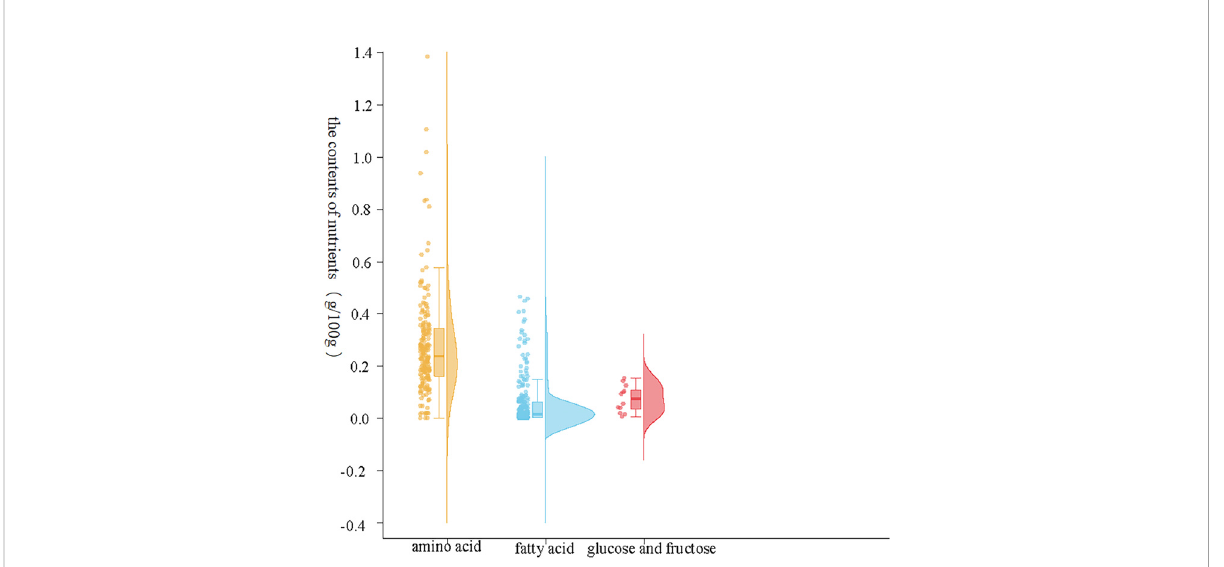
FIGURE 1 Contents of the three major nutrients in maternal plasma. The abscissa represents nutrient elements, in which orange represents the change of amino acid content, blue represents the change of fatty acid content, red represents the change of glucose and fructose content, and the ordinate represents the content composition